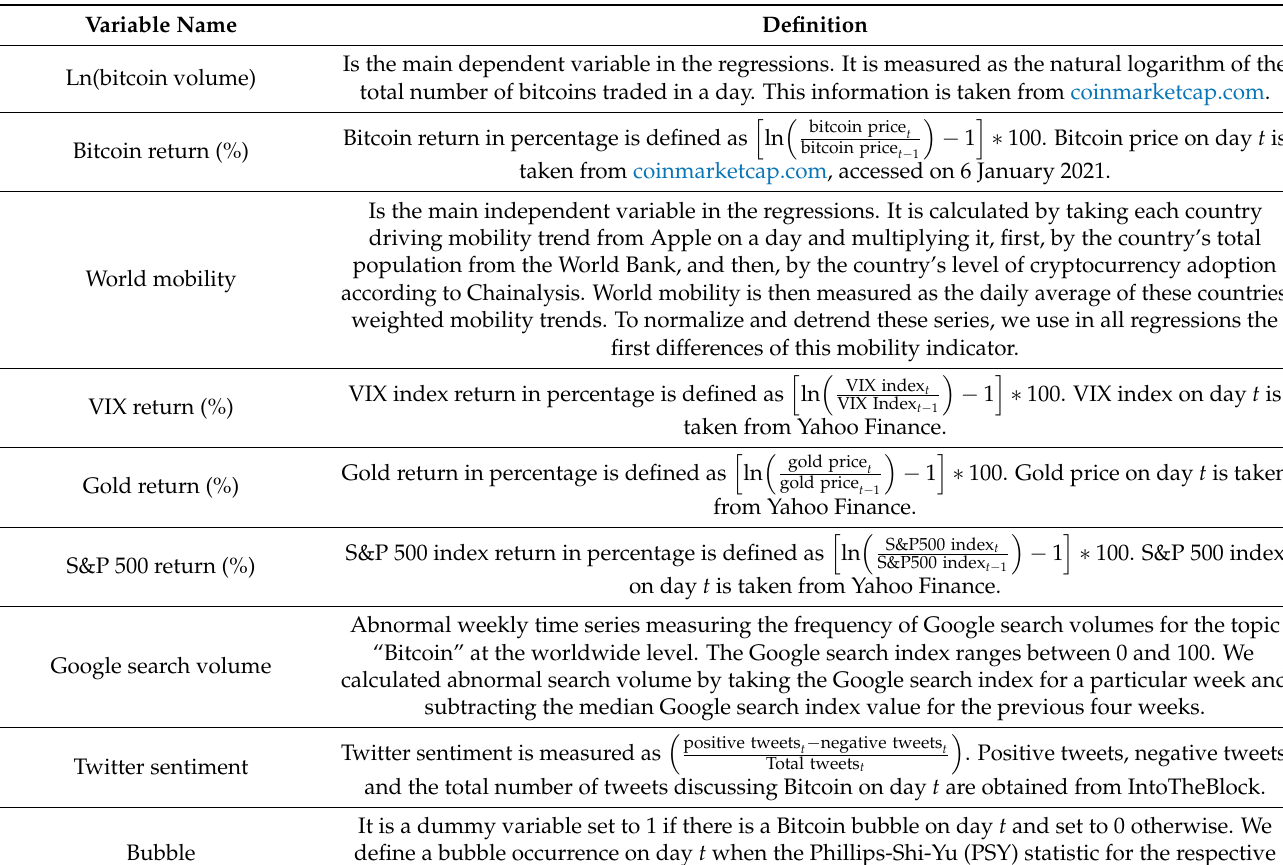
Table A1 defines dependent, independent, and control variables used in this study. Table A1. Definitions of